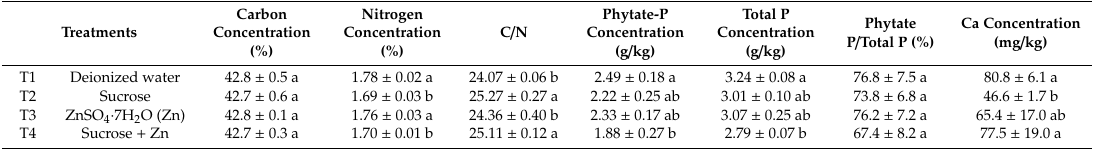
Table 6. E ff ects of di ff erent foliar treatments on the concentrations of carbon, nitrogen, phytate P, total P, and Ca, and ratios of C / N and phytate P / total P in maize grains in the field experiment at Licheng. Carbon Nitrogen Phytate-P Total P Phytate Ca Concentration Treatments Concentration Concentration C / N Concentration Concentration P / Total P (%) (mg / kg) (%) (%) (g / kg) (g / kg) T1 Deionized